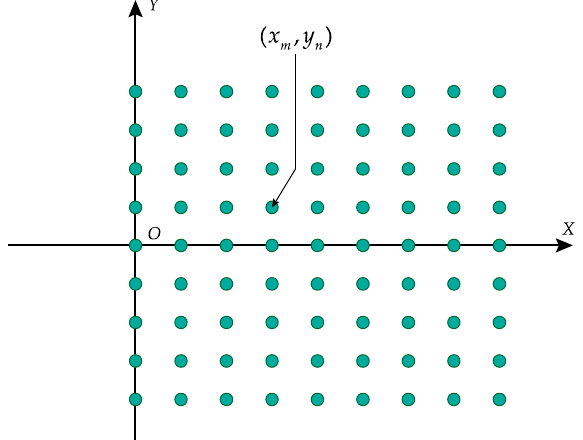
Figure 4. Schematic diagram of imaging pixel distribution.